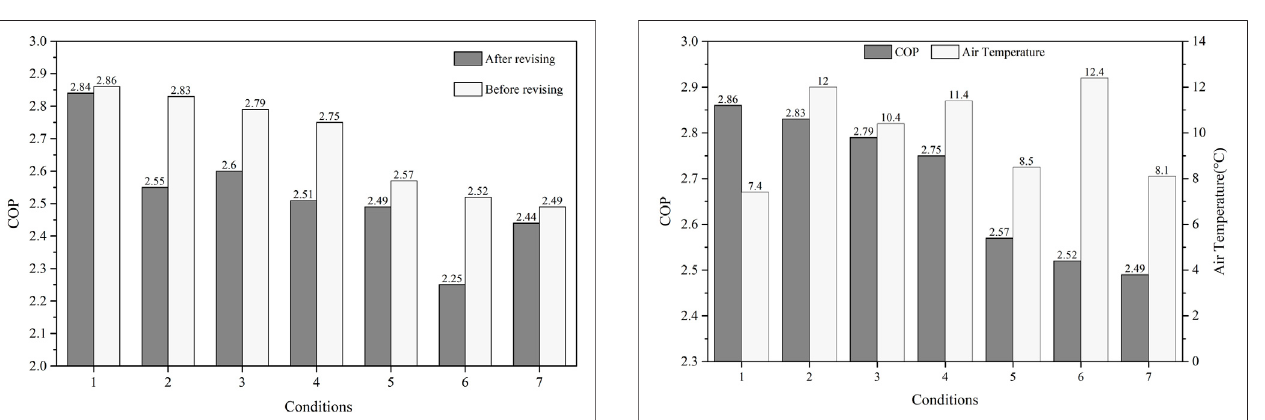
FIGURE 13 | Comparison of the average of the COP of the heating system under different conditions.